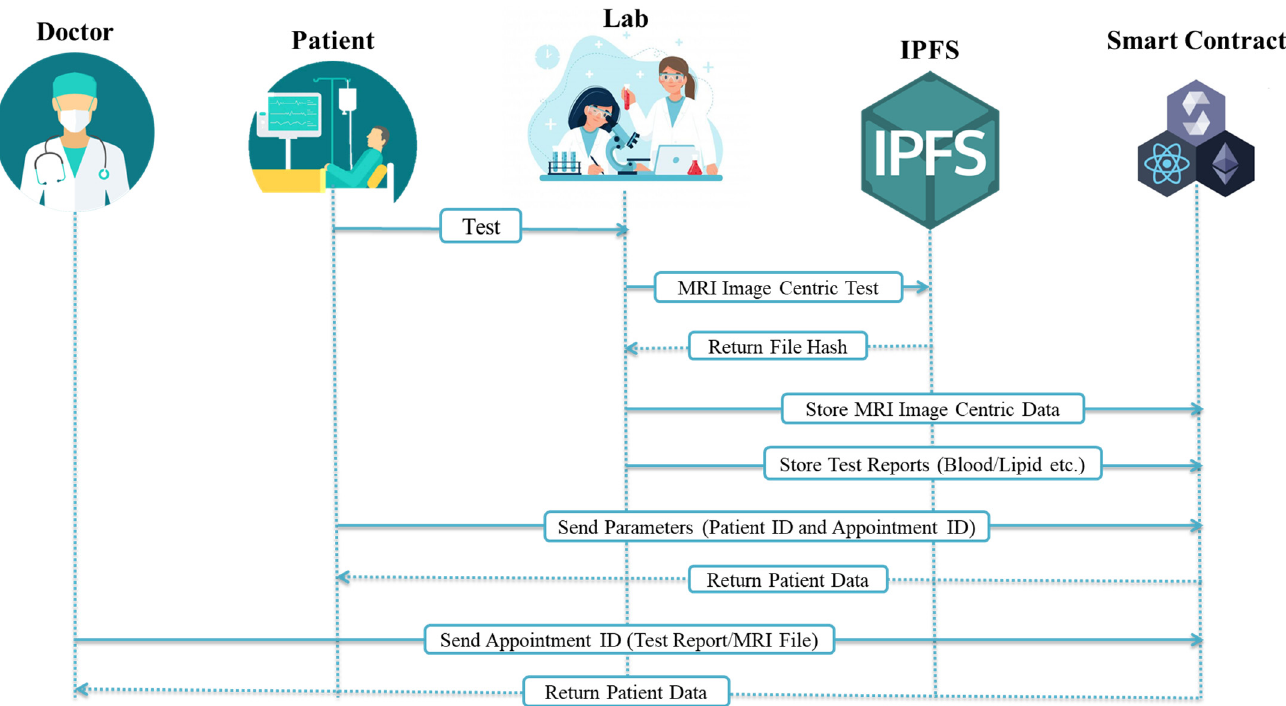
Figure 7. Data-sharing sequence process.